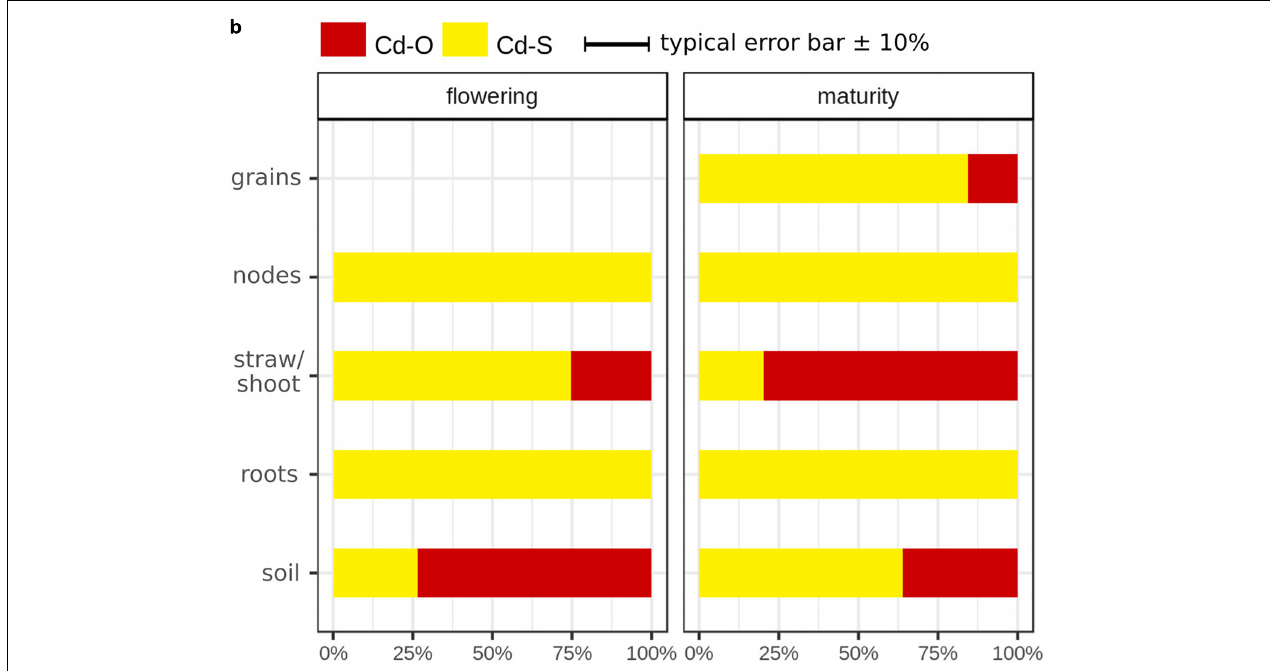
FIGURE 4 | (a) K-edge X-ray absorption near edge structure (XANES) (A) , extended X-ray absorption fine structure (EXAFS) (B) , and Fourier transformed (C) spectra for soils and rice parts that were sampled at flowering (Flow) and maturity (Mat) stage, and for selected Cd reference compounds. For some spectra (e.g., grain_Mat_1), only the XANES spectrum was analyzed because of the low Cd concentration in these samples. Dashed line represents linear combination fits, performed on the XANES (A) and k 2 EXAFS spectra ( B , and their FTs in panel C ). Spectra from soil and root at flowering were taken from in Wiggenhauser et al. (2021). (b) Cadmium (Cd) speciation in different compartments of the soil–rice system at different growth stages. “Cd–O” denotes Cd bound to COOH/OH groups of organic matter or Cd sorbed to minerals, and “Cd–S” represents Cd bound to thiols (R-SH). Detailed results of the linear combination fits can be found in Supplementary Table 6 . The error bar represents a typical precision for Cd speciation analysis with XAS (see the section “Statistics”). Speciation results from soil and root at flowering were taken from Wiggenhauser et al.